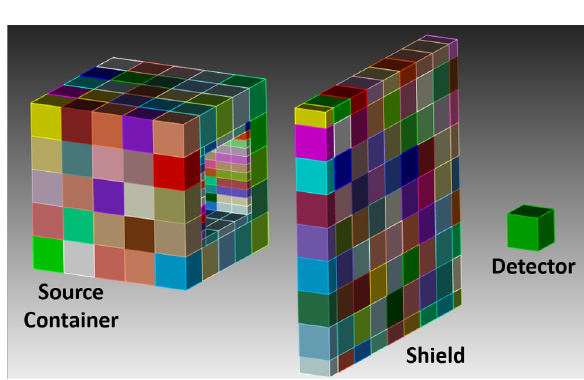
Figure 7: Detector shielding problem geometry